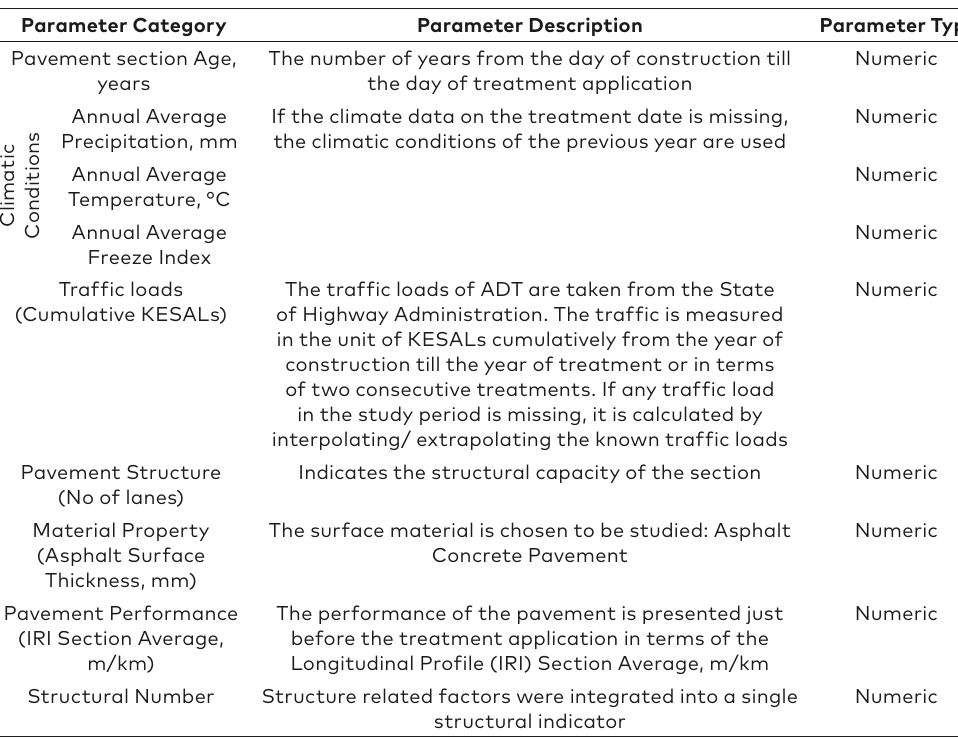
Table 3. Parameter description and